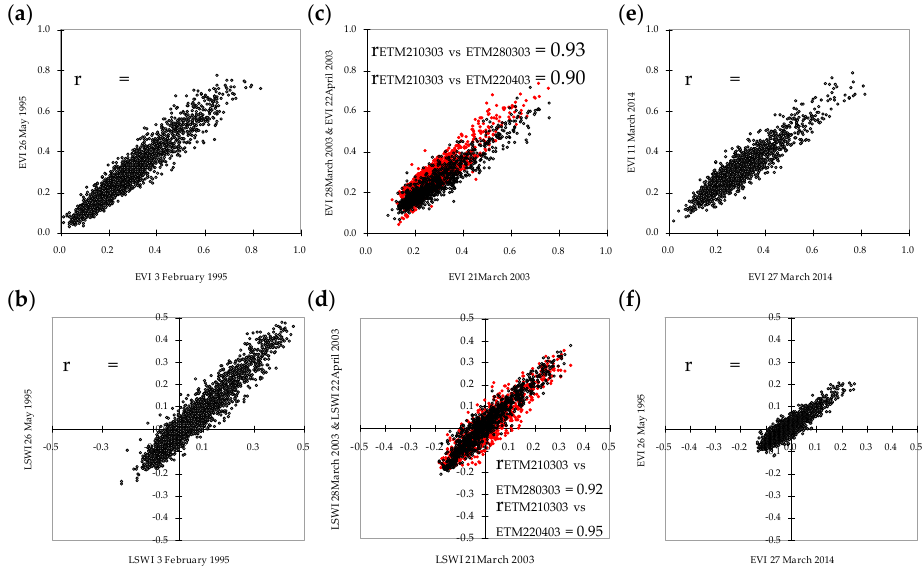
Figure 2. Scatter plots of the Landsat base index from the main data with the data used for patching the no-data regions caused by clouds and their shadows. Top panels present enhanced vegetation index (EVI) and bottom panels present land surface water index (LWSI). ( a , b ) for Landsat 5 on 3 February 1995 with 26 May 1995; ( c , d ) for Landsat 7 on 21 March 2003 with 28 March 2003 (black dots) and for 21 March 2003 with 22 April 2003 (red dots); and ( e , f ) for Landsat 8 on 27 March 2014 with 11 March 2014.